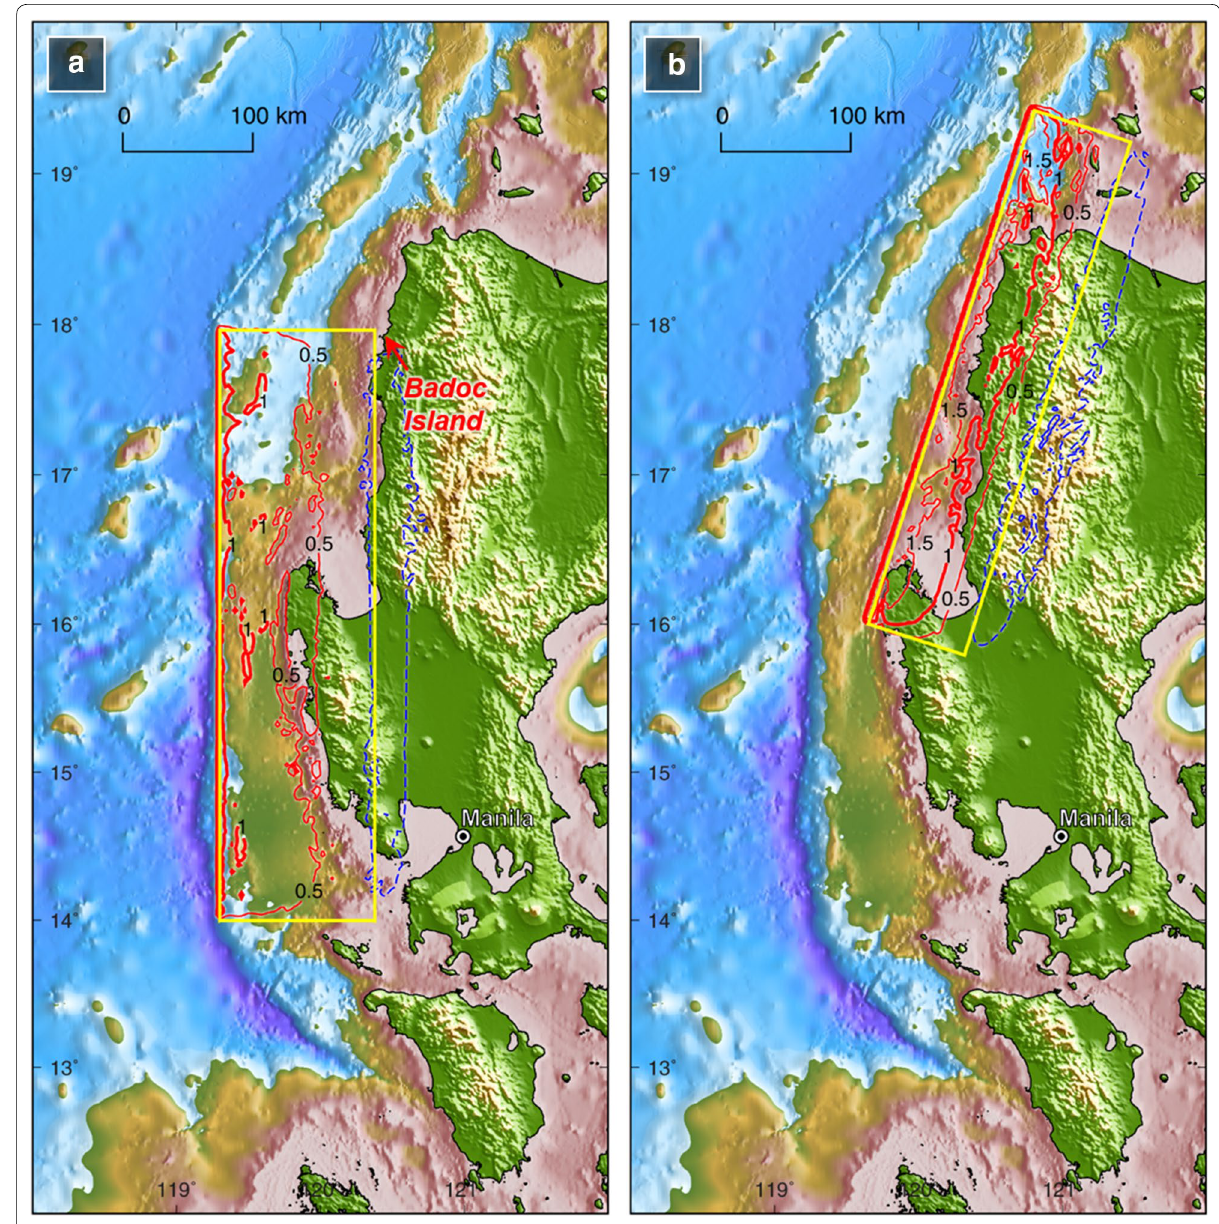
Fig. 4 Hypothetical fault rupture scenarios showing uplift ( red ) and subsidence ( blue ) along west Luzon Island. Contours and numbers indicate amount of deformation in meters. a Fault rupture along the Manila Trench megathrust could lead to uplift of coastlines closer to the subduction zone (i.e., Pangasinan) but will largely cause subsidence along the west coasts of the Ilocos region. b Rupture of an offshore upper‑plate reverse fault on the northern forearc region is modeled to approximate the deformation pattern of the lowest Holocene terraces in west